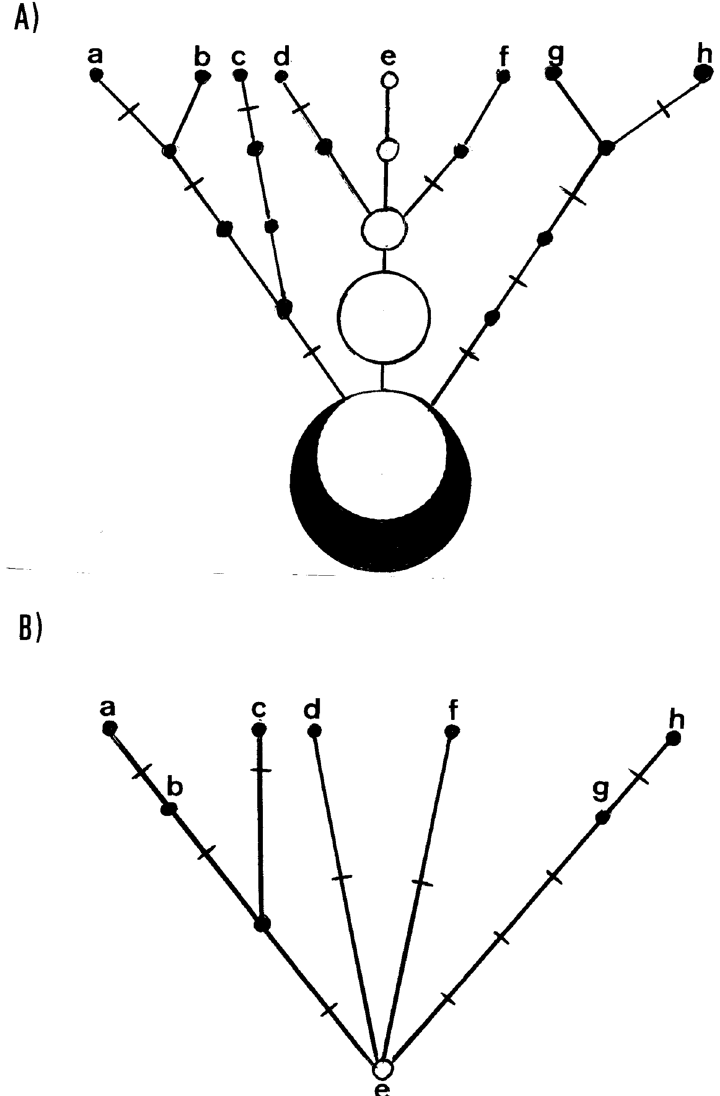
Figure 2. Comparison between a genealogy ( A ) and a tree ( B ) constructed from the same sample (a to h). White circles are individuals with the ancestral lineage, black circles are individuals with additional mutations. Inter-circle segments represent generations and crosses on the segments represent